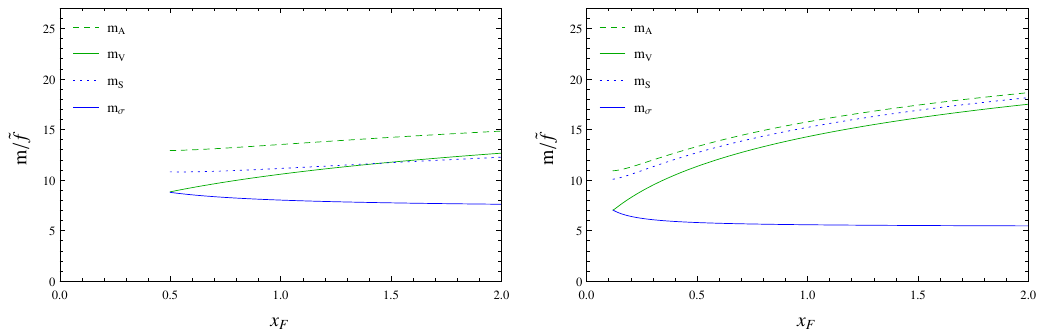
˜ f as a function of x F = N F /N C , for ξ = 1 . 3 and κ B /κ A = 0 . 5 = 0 . 7 (right B /κ A